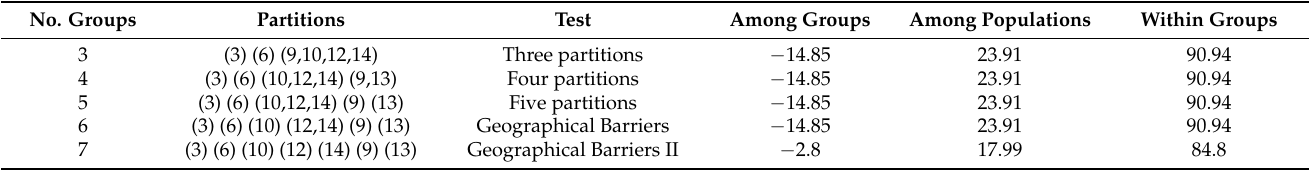
Table 5. Results from the analysis of the molecular variances (AMOVA). Data were partitioned to test the effect of the region (Pacific coast, Amazon basin, and Galapagos Islands), as well as the effect of geographical regions. No.